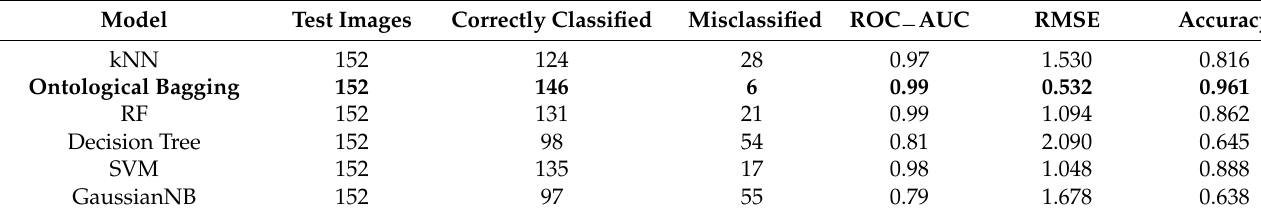
Table 6. Quantitative comparison of models.